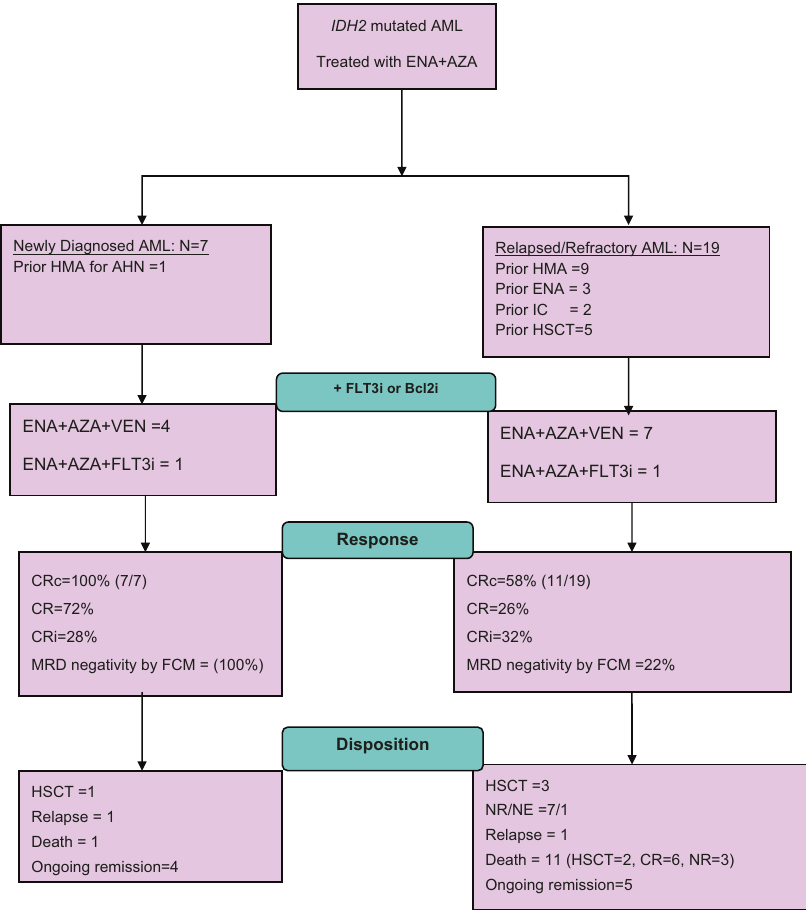
Fig. 1 Consort diagram of Phase II trial of ENA + AZA combination in IDH2 mut AML. Consort diagram. AML- Acute myeloid leukemia, ENA- Enasidenib, AZA- Azacitidine, HMA- hypomethylating agent, AHN- antecedent hematological neoplasm, IC- intensive chemotherapy, HSCT- Hematopoietic stem cell transplant, i- inhibitor, VEN- venetoclax, CRc- composite complete remission, CR- complete remission, CRi- complete remission with incomplete hematological recovery, MRD- measurable residual disease, FCM -Flowcytometry, NR -no response, NE- not